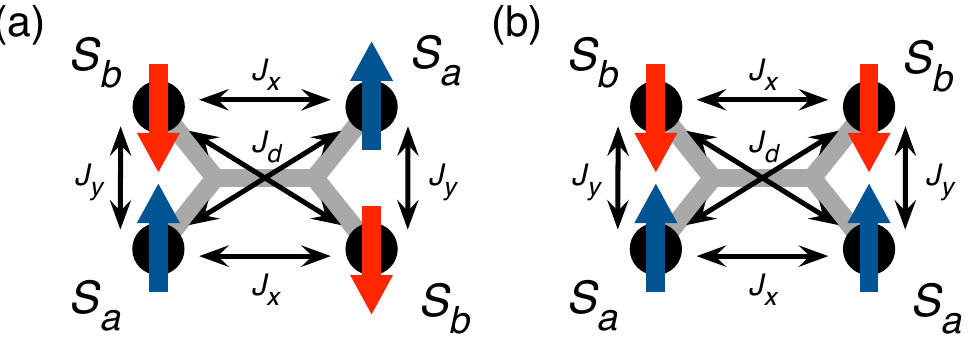
Figure 5. Sketch of the Mn–TCNQ lattice showing the relevant magnetic couplings between the Mn atoms. The four-leg TCNQ molecules mediate by superexchange an antiferromagnetic interaction between the nearest neighbors on the lattice (couplings J x and J y ) as well as between the next-to-nearest neighbors (coupling J d ). For a sufficiently small-magnitude J d , the tendency is to order the spins in the checkerboard pattern ( a ). With increasing the magnitude of J d , a crossover to ordering spins in rows or columns takes place ( b